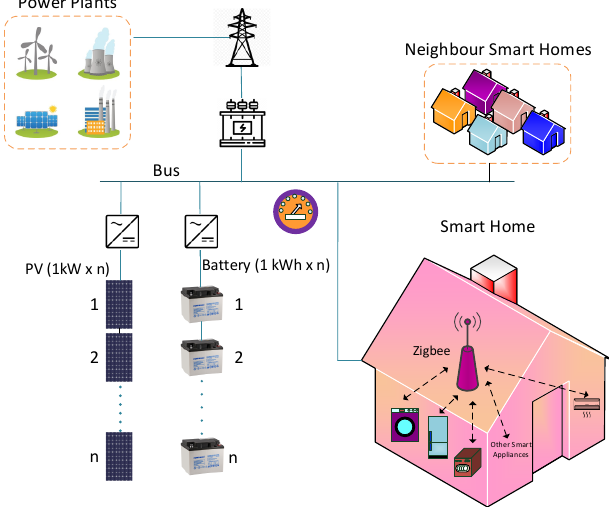
Figure 1. Proposed structure of smart home with photovoltaic (PV) – battery hybrid system.